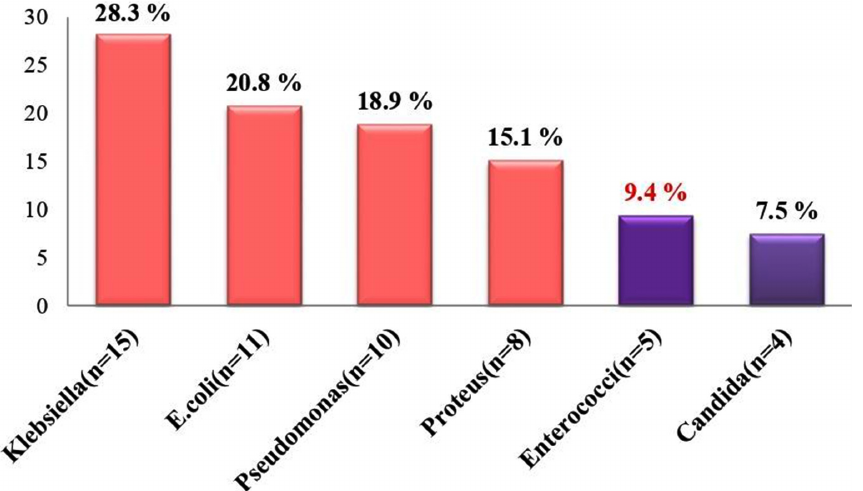
Fig. 2. Associated co-pathogens with nosocomial MRSA isolates: Gram negative bacilli were common co-pathogens. All the associated Enterococci were VA